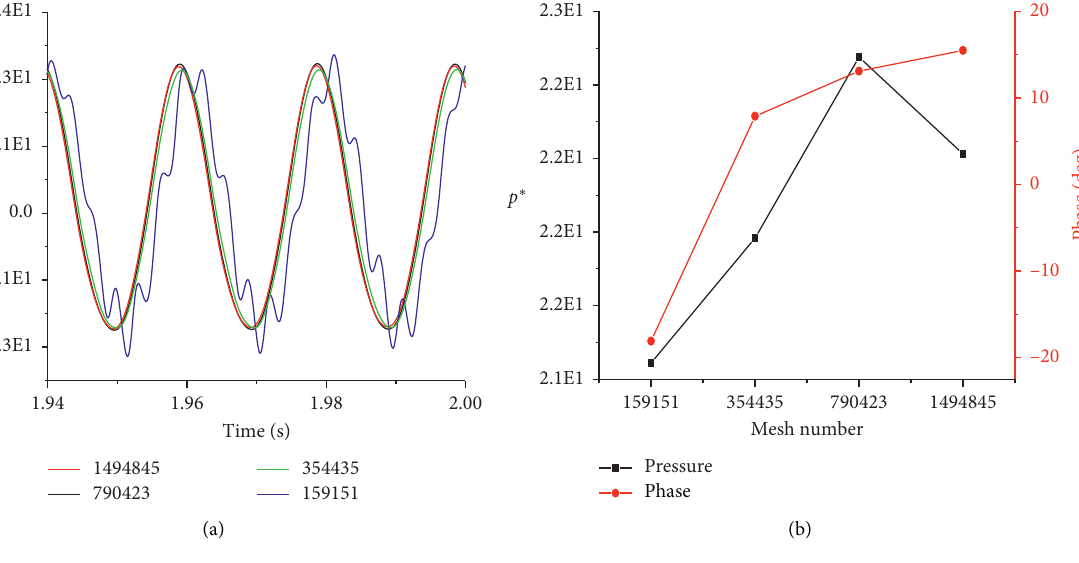
Figure 4: Verification for grid independent solutions.